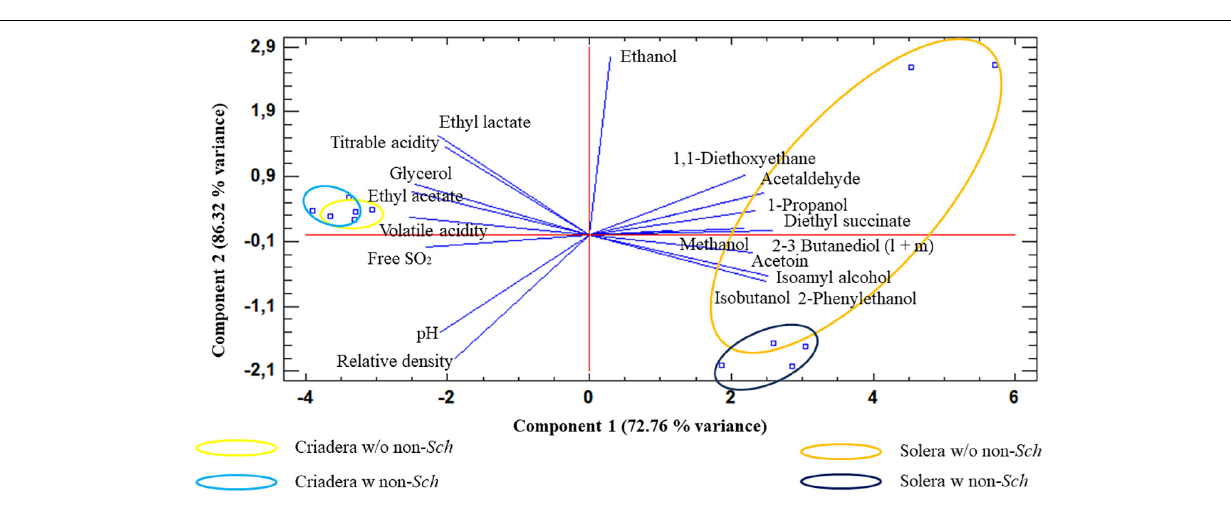
FIGURE 6 | Principal component analysis of wines with different aging times and the presence of non- Saccharomyces yeast. The analysis was carried out with all studied variables. Solera w/o non- sch , Solera wine without non- Saccharomyces ; Solera w non- sch , Solera wine with non- Saccharomyces ; Criadera w/o non- sch